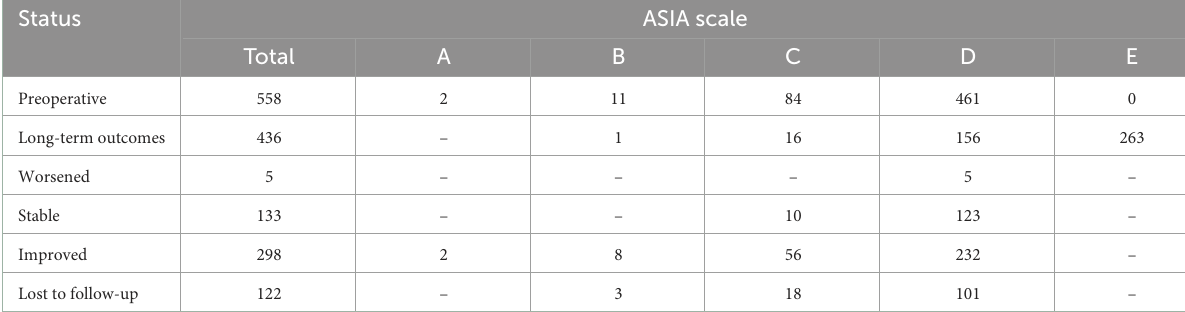
TABLE 3 Postoperative neurological improvement of the patients.